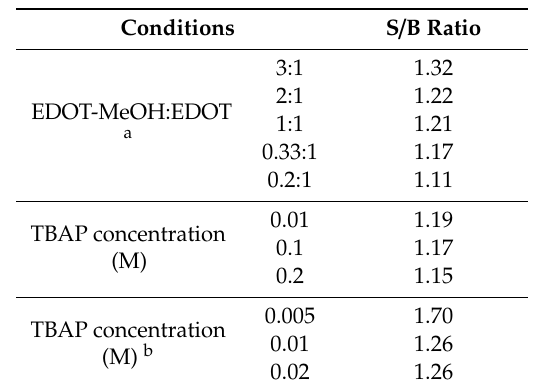
Table 1. The S / B ratio of DA detection by MOF525 / PEM modified microelectrode under various synthesis conditions.